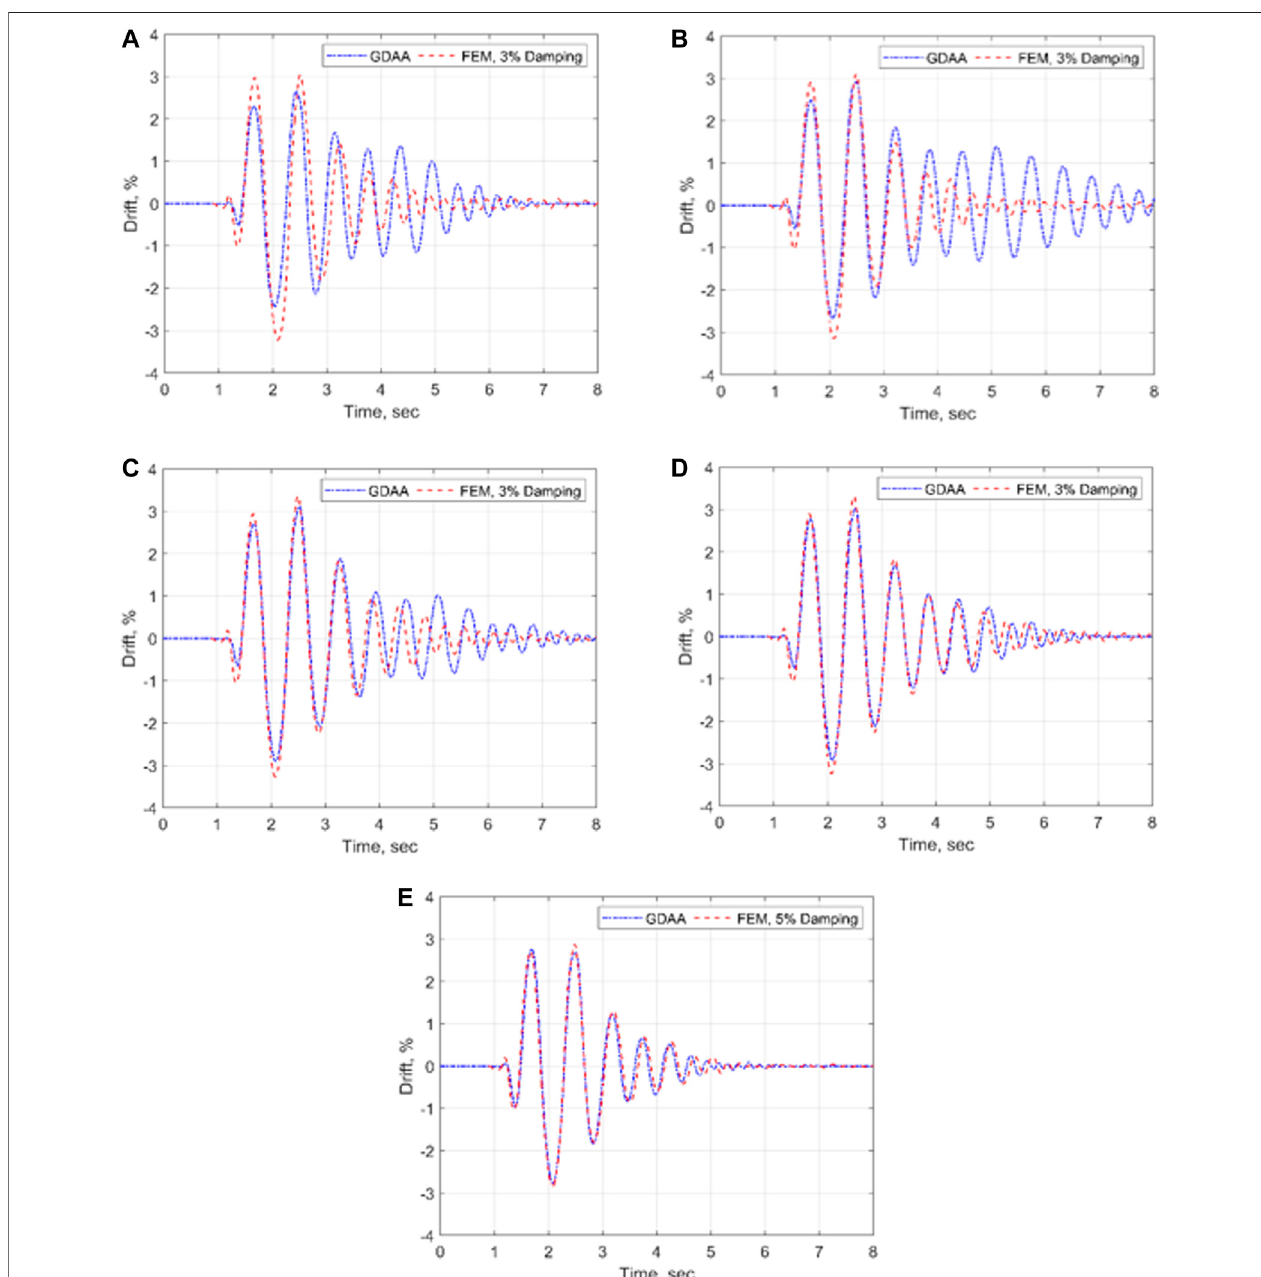
FIGURE 13 | Lateral drift time histories of case study SRWs during Sylmar – the FEM with selected damping ratios vs the GDAA: (A) Case B, with aspect ratio of 4; (B) case C, with aspect ratio of 3.5; (C) Case D, with aspect ratio of 3; (D) Case E, with aspect ratio of 2.5; (E) Case F, with aspect ratio of 2.